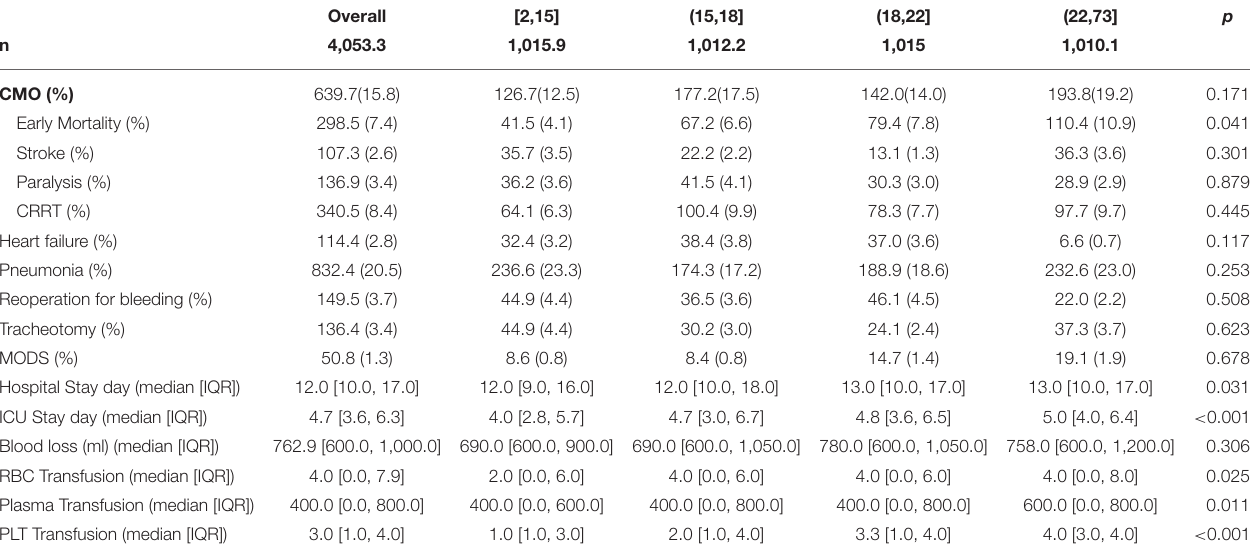
TABLE 3 | Outcome data after matching.